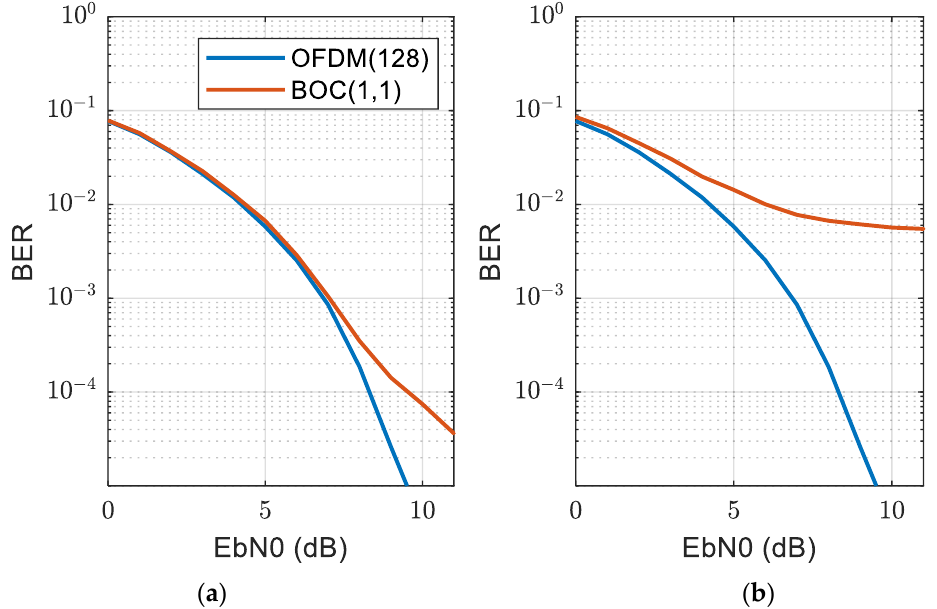
Figure 15. Bit error rate of the communication signal varies with the signal-to-noise ratio. ( a ) When the power ratio of communication and navigation signals is 20 dB; ( b ) When the power ratio of communication and navigation signals is 10 dB.